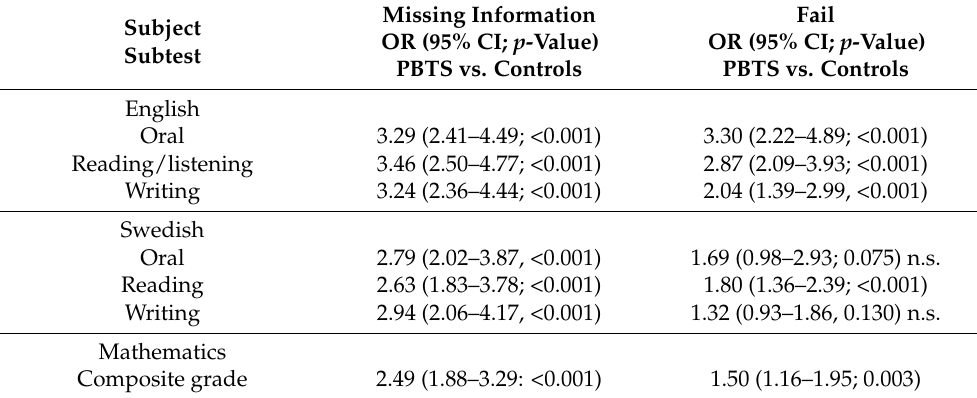
Table 4. Odds ratio (OR), 95% confidence intervals (95% CI) and p -values regarding missing informa- tion and fail in the national tests and subtests in English, Swedish and mathematics year 9 for PBTS and controls. n.s. = not